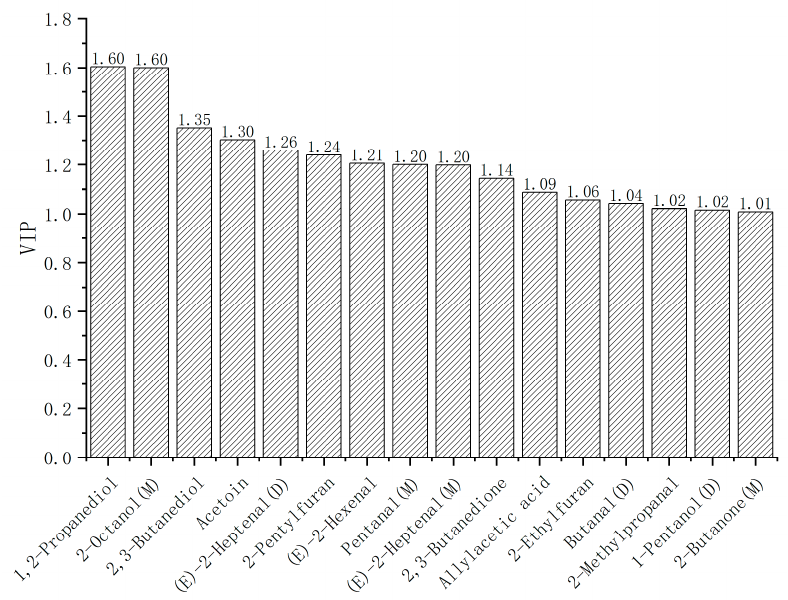
Figure 7. Volatile organic compounds with VIP >